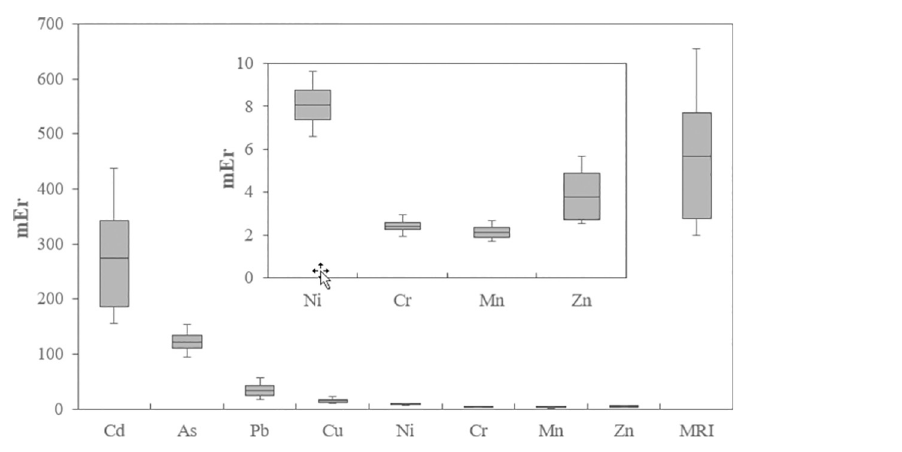
Fig 6. Box-plots of mEr and MRI for heavy metals in the urban soil samples of Yazd.